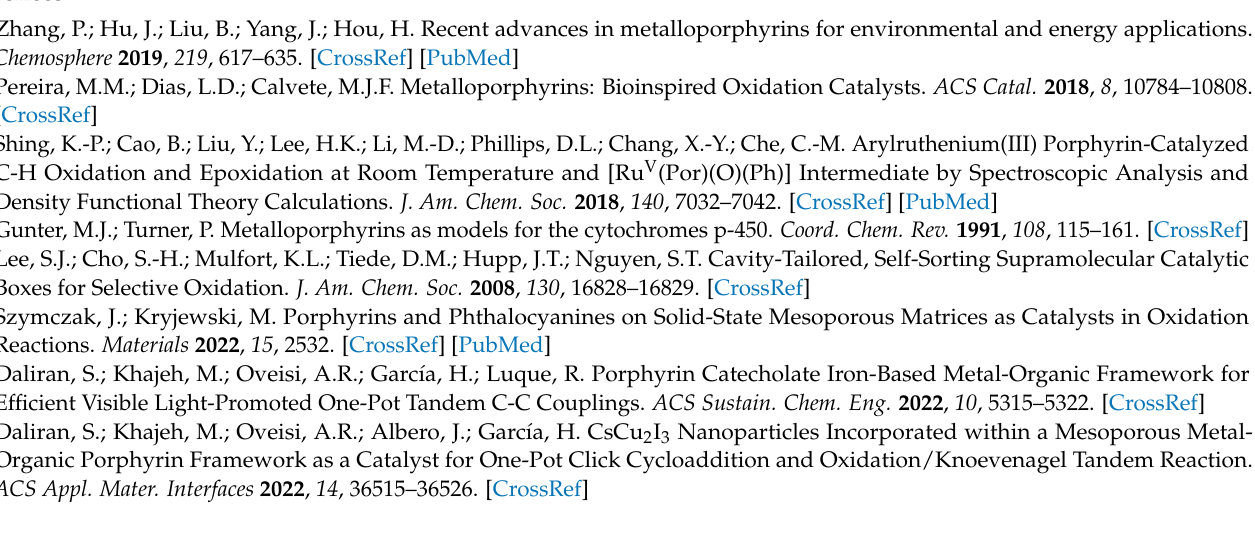
Figure S2: 13C NMR spectrum of 2-benzylidenemalononitrile; Figure S3: 1H NMR spectrum of 2-(4- chlorobenzylidine)malononitrile; Figure S4: 13C NMR spectrum of 2-(4-chlorobenzylidine)malononitrile; Figure S5: 1H NMR spectrum of 2-(4-methylbenzylidene)malononitrile; Figure S6: 13C NMR spec- trum of 2-(4-methylbenzylidene)malononitrile; Figure S7: 1H NMR spectrum of 2-(3-nitrobenzylidene) malononitrile; Figure S8: 13C NMR spectrum of 2-(3-nitrobenzylidene)malononitrile; Figure S9: FT-IR spectra of fresh (a) and reused (b) Porph-UOZ-COF; Figure S10: FT-IR spectra of monomers: (a) DHPP and (b) DBBA; Figure S11: TGA/DSC profile of the COF; Figure S12: GC/MS spectrum of benzaldehyde as the intermediate (retention time of ~7.8). References [48–50] are cited in the Supplementary